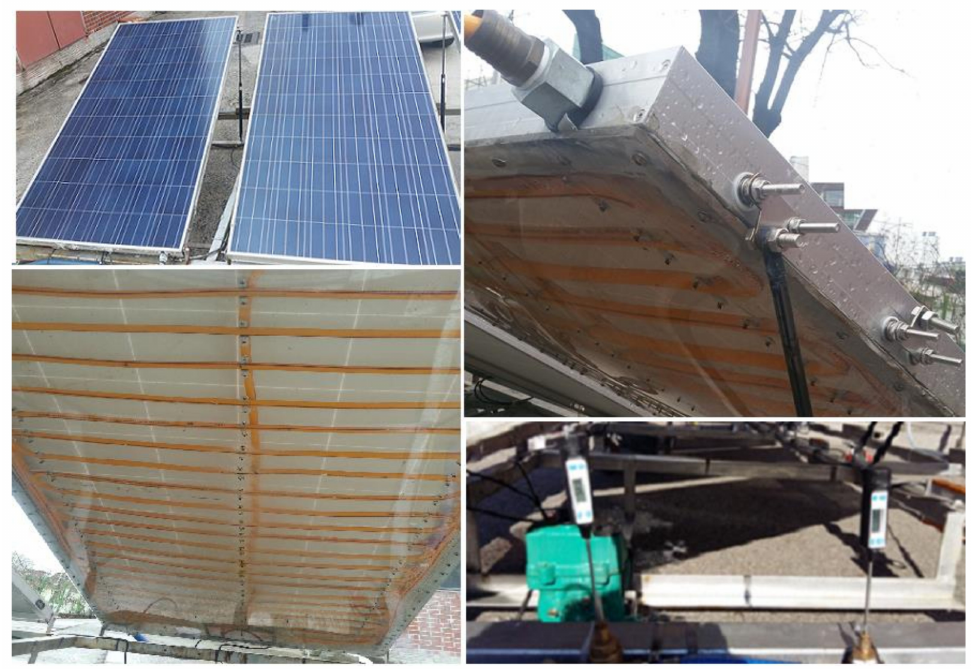
Figure 8. Experimental setup for proposed closed-loop cooled solar system